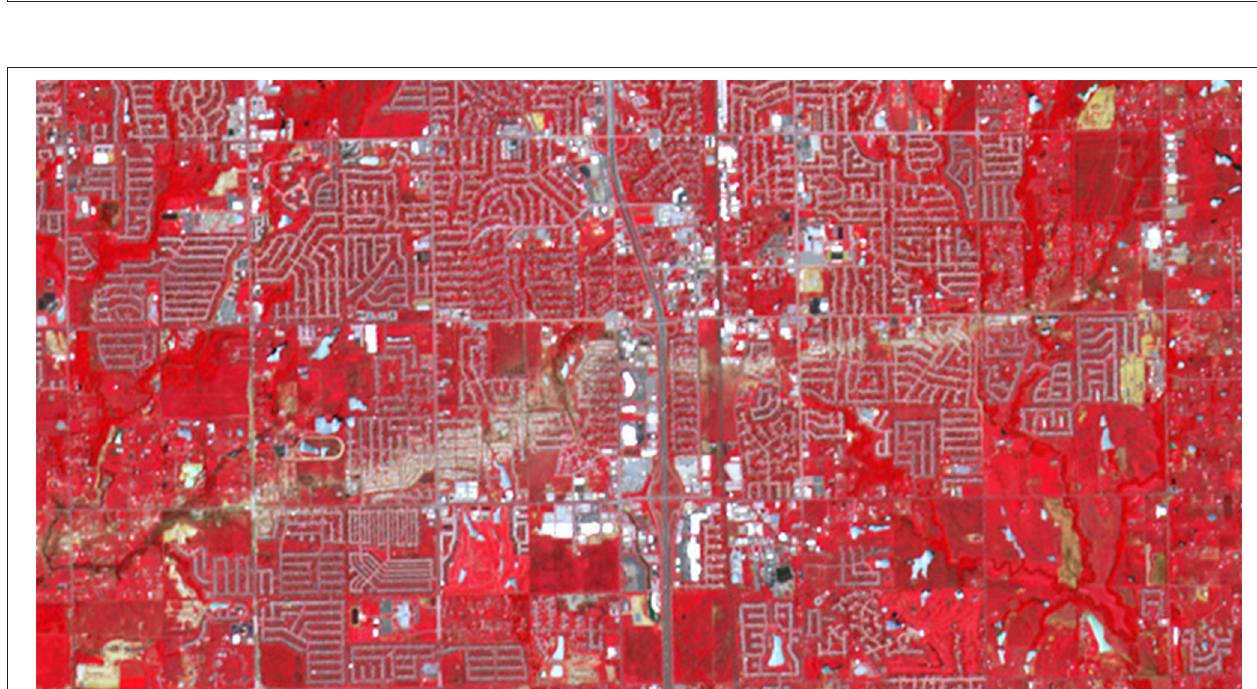
FIGURE 3 | Track of the EF-5 tornado that struck Moore, OK, on May 20, 2013 is visible in the false-color image composed of infrared, red, and green bands acquired by the Advanced Spaceborne Thermal Emission and Reflection Radiometer (ASTER) on board NASA’s Terra satellite on June 2, 2013. In this false-color image, vegetation appears as red, and the tornado track (absence of vegetation) is clearly evident. Spatial resolution 15m. Image credit: NASA (public domain).